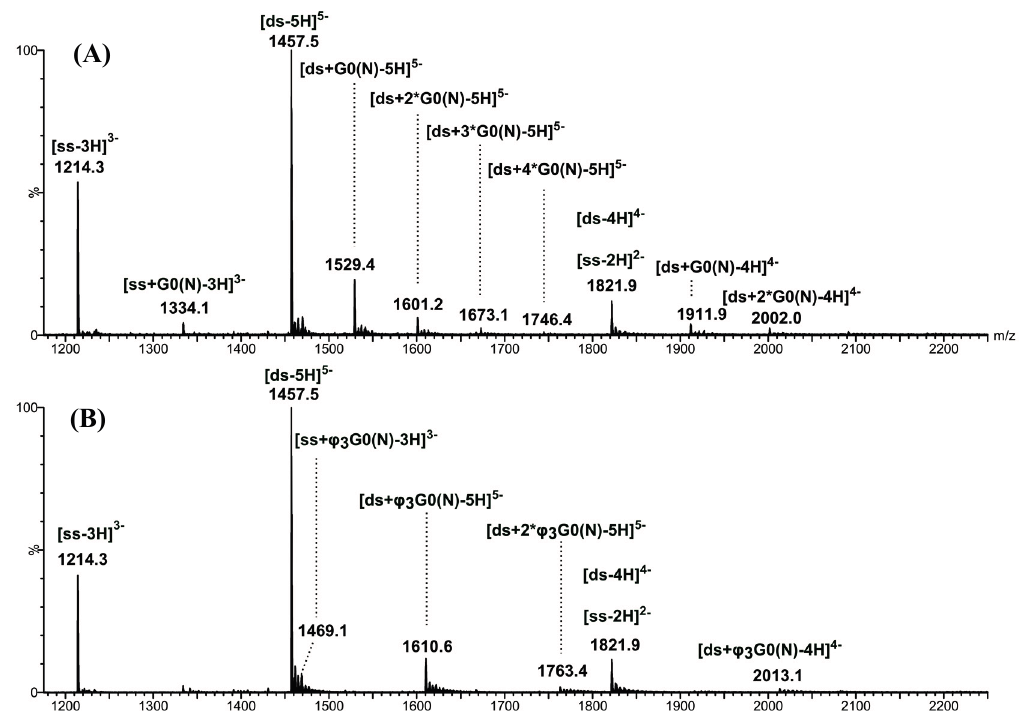
Figure 4. Negative-ion ESI mass spectra of [ ds /G0(N)] dendriplex ( A ) and [ ds / φ 3 G0(N)] dendriplex ( B ) in 1:10 molar ratio solution.